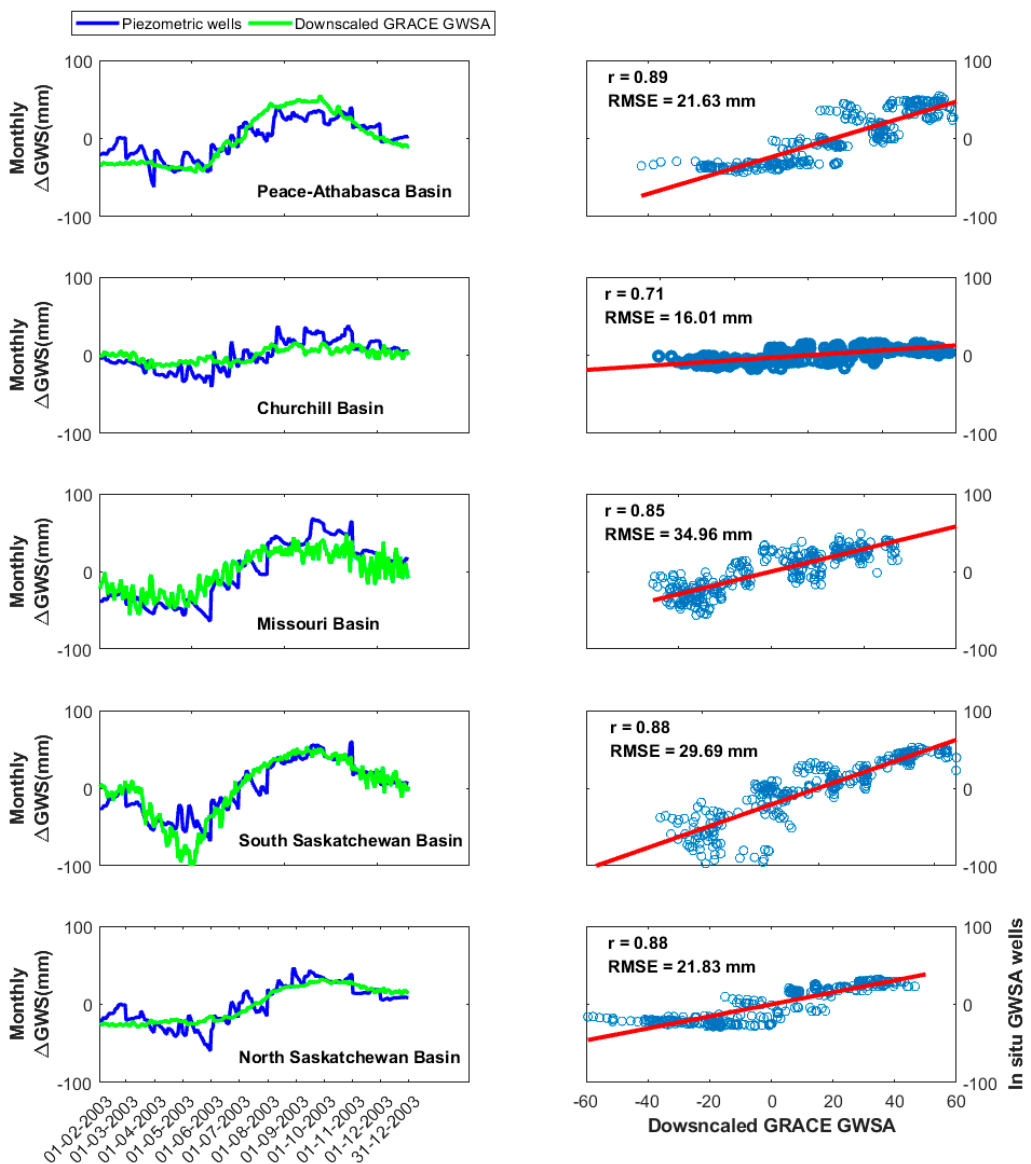
Figure 14. Time series ( left panels) and scatter plots ( right panels) of groundwater storage anomaly (GWSA) temporal variations from daily downscaled GRACE compared to five different daily piezometric wells (latitudes and longitudes: 55.2935, − 118.461; 54.5596, − 111.589; 49.1039, − 110.251; 52.0117, − 114.215; and 53.3876, − 112.829, respectively) over the selected river basins in Alberta from February to December 2003 [mm].